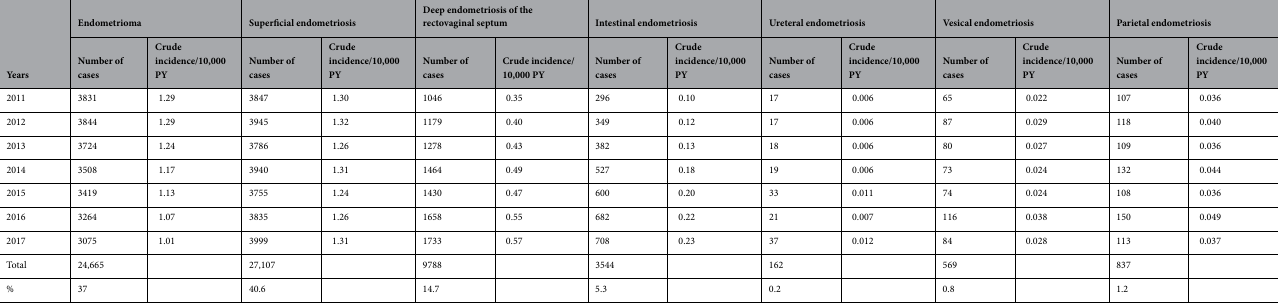
Table 4. Number of incident cases of hospitalized endometriosis and crude incident rate for specific types of endometriosis for the study period in the whole of France, in females aged 10 years and above. PY